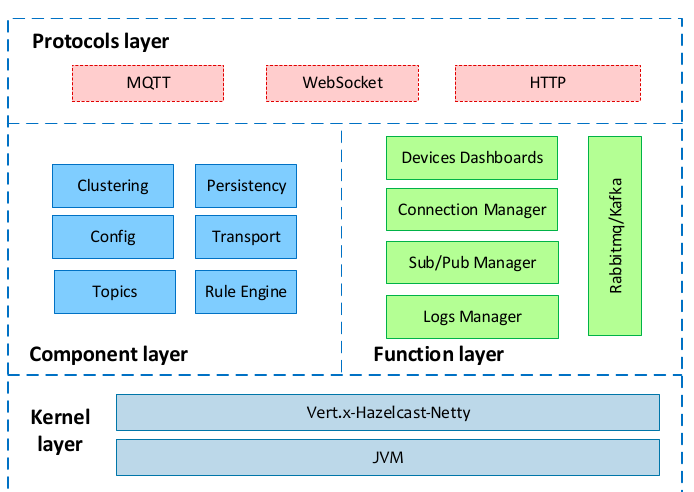
Figure 14. The software architecture of an MQTT broker, utilized by EMULSION.